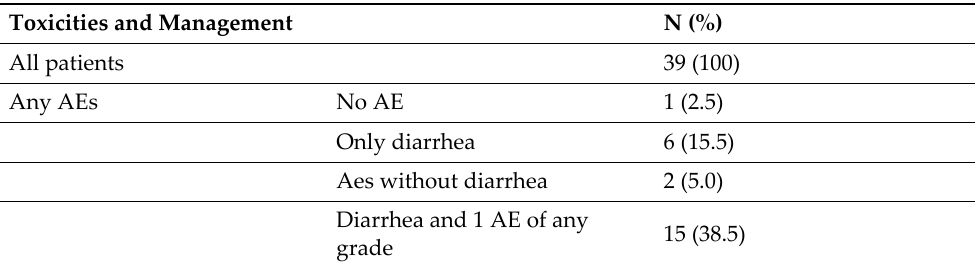
Table 2. Abemaciclib‑induced toxicities and